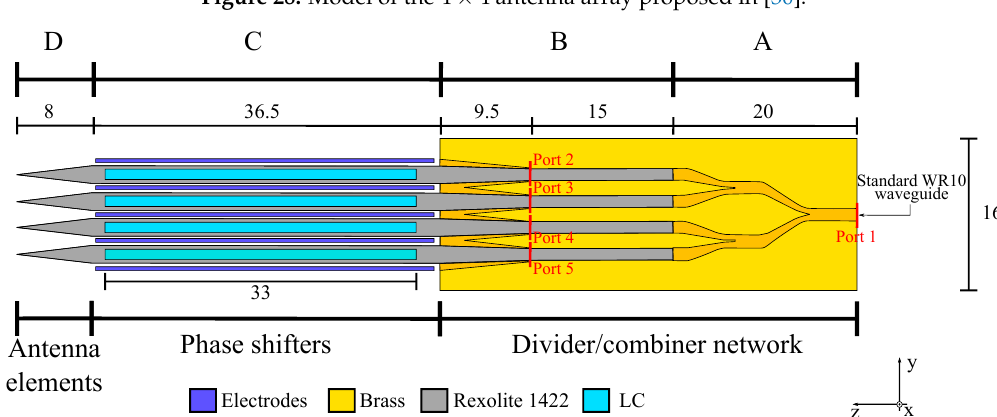
Figure 28. Model of the 4